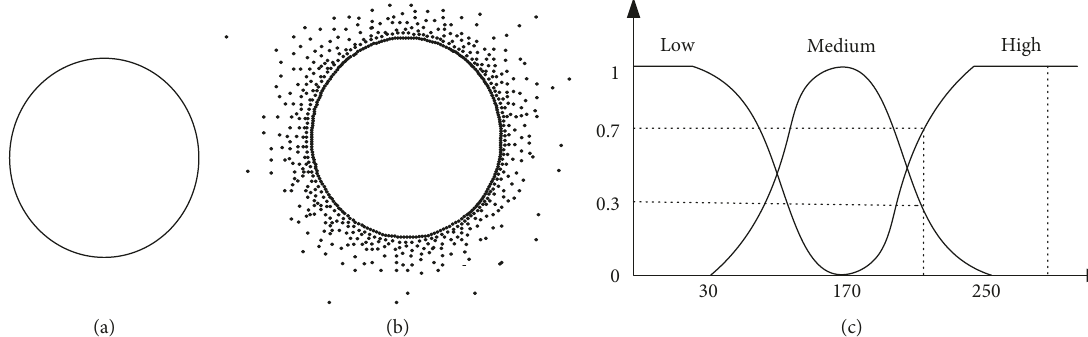
Figure 2: (a) Diagram representing the Boolean logic used in the classical set theory; (b) modi fi ed Venn diagram of a fuzzy set; (c) a membership function graph with height as an